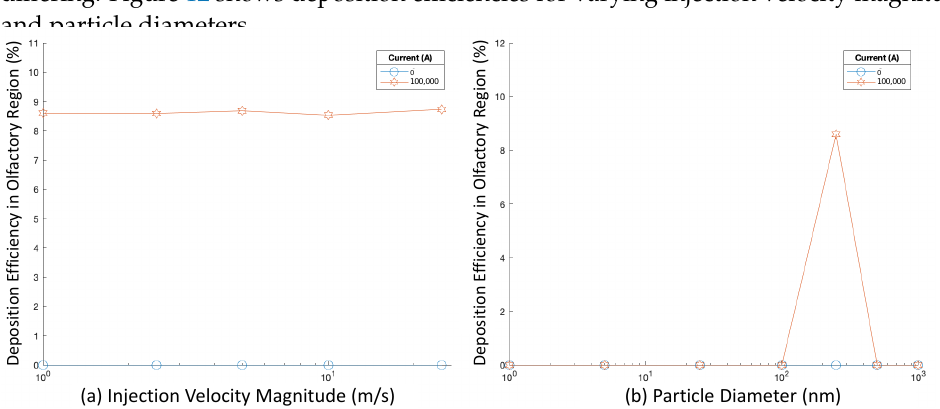
Figure 12. Deposition efficiency with varying magnetic fields for varying injection velocity magni- tudes and diameters for targeted injections: ( a ) Deposition efficiency vs. injection velocity, and ( b ) Deposition efficiency vs. injection angle.